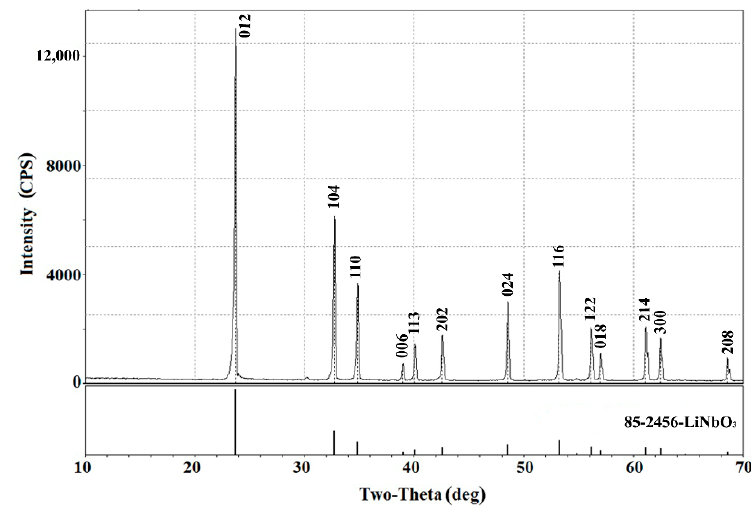
Figure 1. X-ray diffractogram of powder lithium niobate synthesized in molten lithium chloride at 700 °C used in experiments on the modification of their cationic composition.